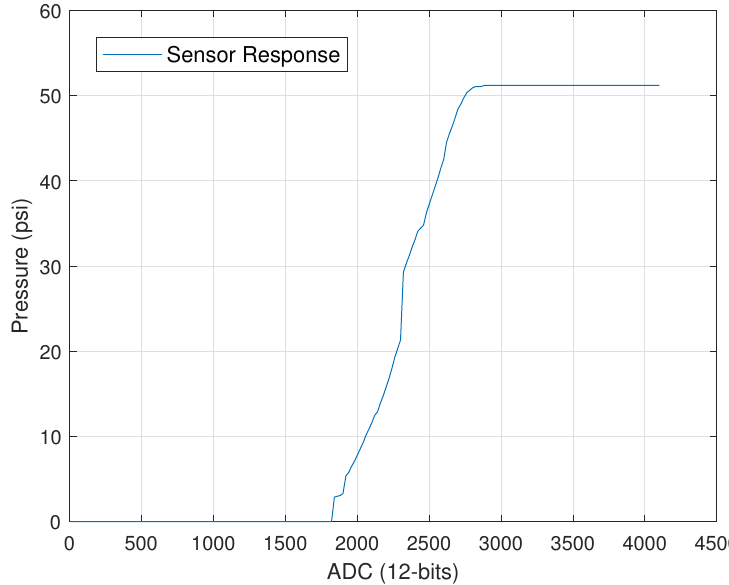
Figure 3. Pressure sensing control scheme of FISAs